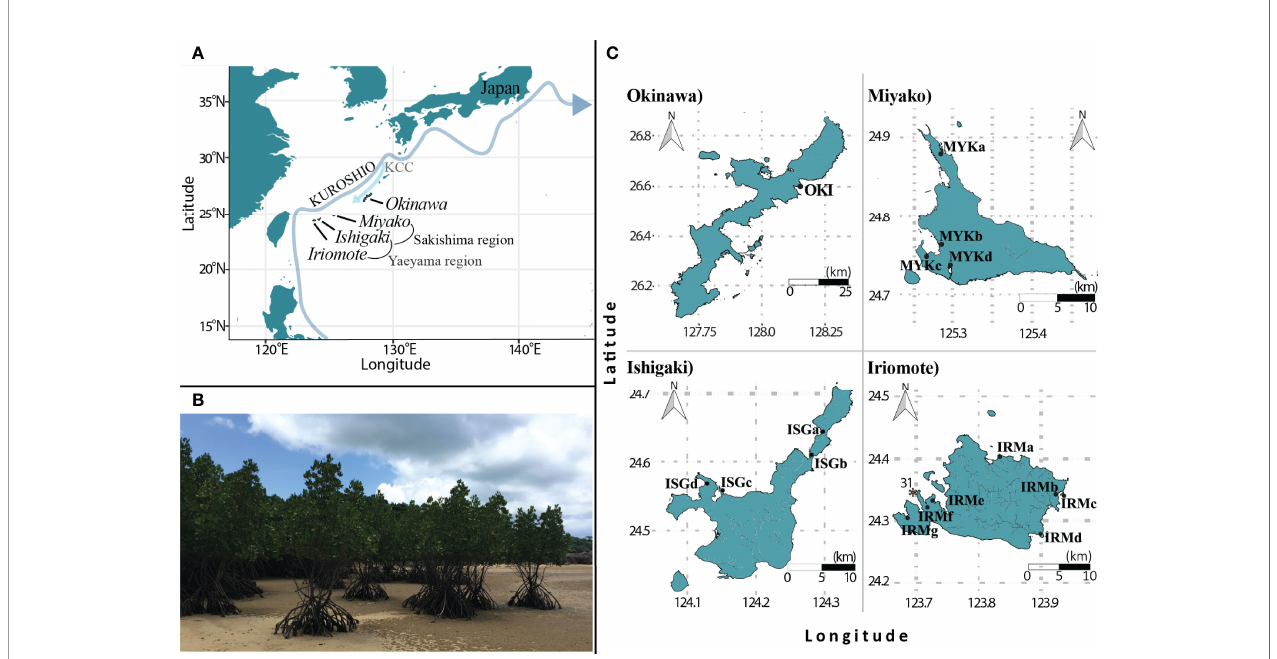
FIGURE 1 | The Ryukyu Archipelago is located in southwestern Japan, spanning 545 km (A). Okinawa, Iriomote, Ishigaki, and Miyako Islands served as study sites. Each fi lled circle shows sampling sites with their location IDs. All sampling sites were natural, non-riverine coastal habitats (B) , except for site OKI (C) which is located in a river mouth, and is the most northern site for R. stylosa . * shows the location of a deployment site for drifting buoys with the number of buoys deployed for in situ experiments. KCC (Kuroshio Counter